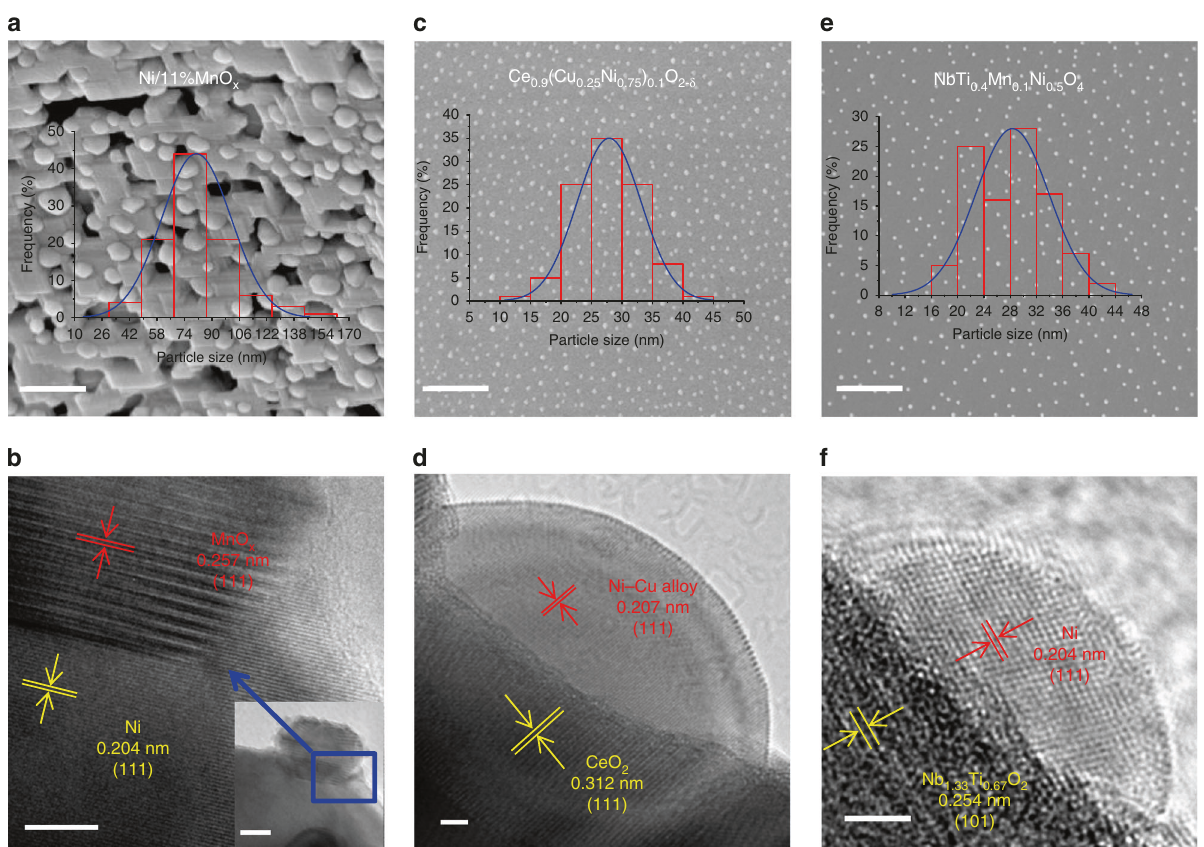
Fig. 2 SEM and HRTEM micrographs for samples. a , b Reduced Ni/11%MnO x samples. c , d Reduced Ce 0.9 (Cu 0.25 Ni 0.75 ) 0.1 O 2 − δ sample. e , f Reduced NbTi 0.4 Mn 0.1 Ni 0.5 O 4 samples. The scale bar is 5 nm in a – c and e . The scale bar is 5 nm in b and the scale bar is 10 nm in the inset in b . The scale bar is 2